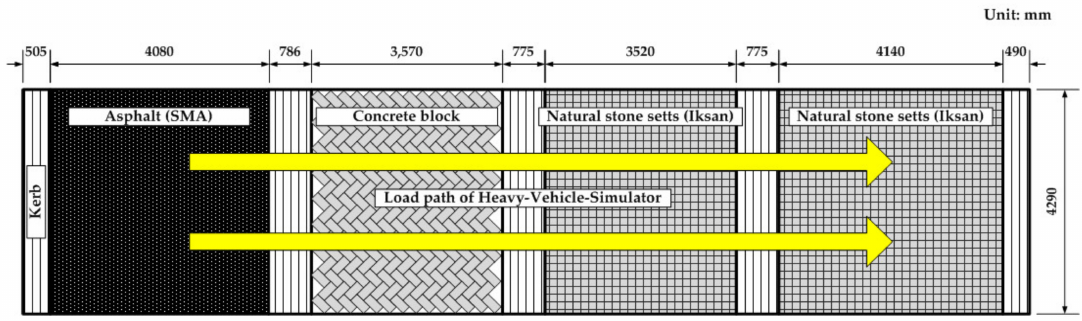
Figure 3. Layout of the test